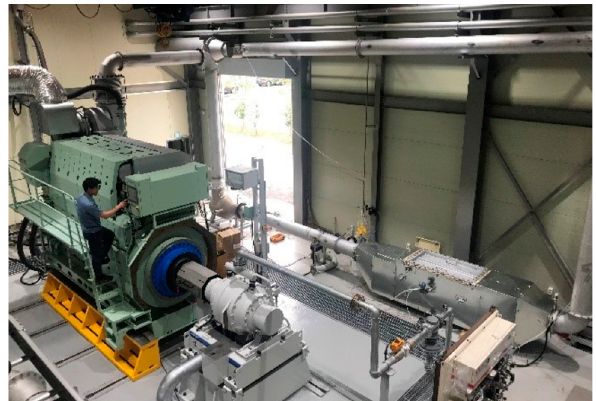
Figure 4. SCR system with a plasma burner.